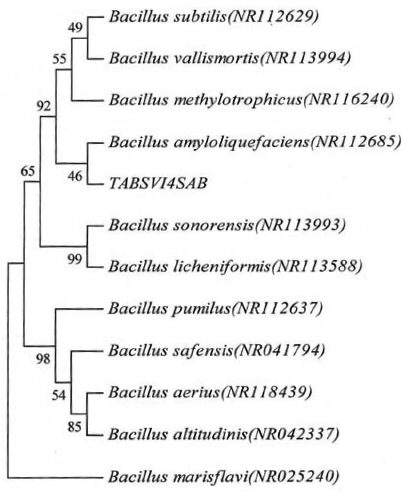
FIGURE 10 - Neighbor-joining tree based on 16S rRNA (1550) sequences showing the relationship between unknown isolate TABSIV4SAB) and other closely related species of the genus Bacillus